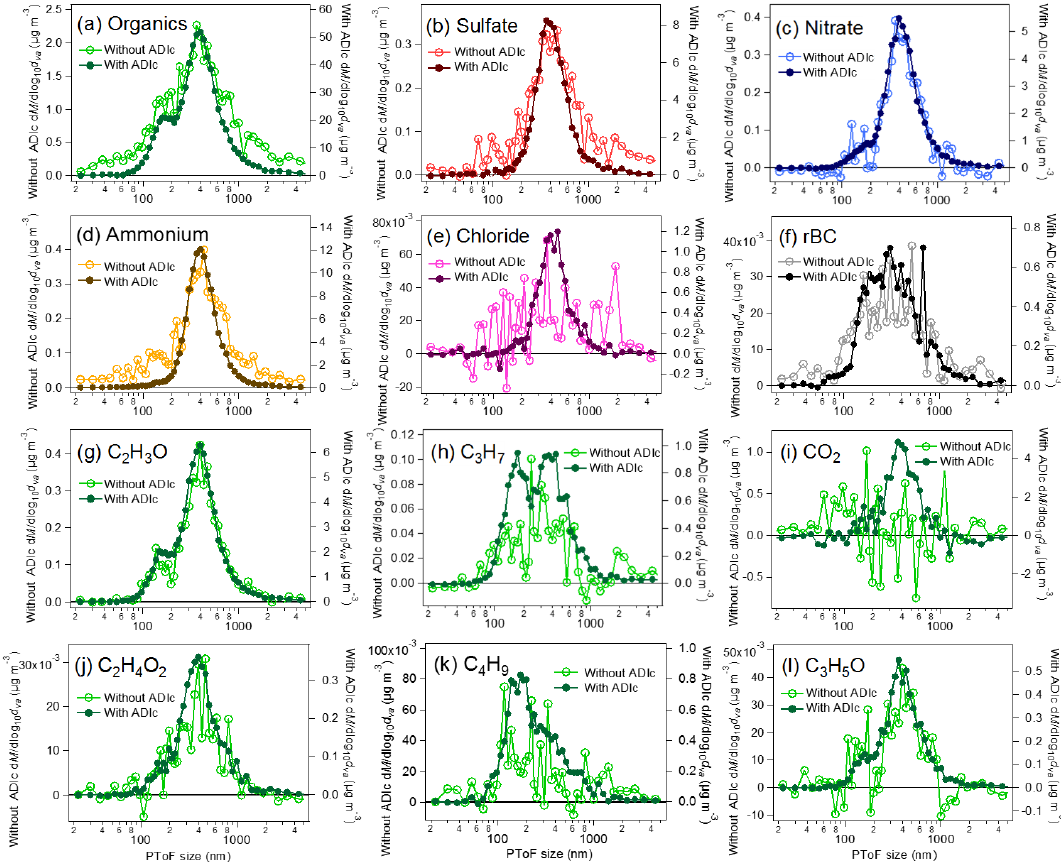
Figure 6. Mass size distributions measured without (left axis) and with the ADIc (right axis) for organics (a) , sulfate (b) , nitrate (c) , ammo- nium (d) , chloride (e) , rBC (f) , C 2 H 3 O (g) , C 3 H 7 (h) , CO 2 (i) , C 2 H 4 O 2 (j) , C 4 H 9 (k) and C 3 H 5 O (l) in HR mode at SMEAR III.